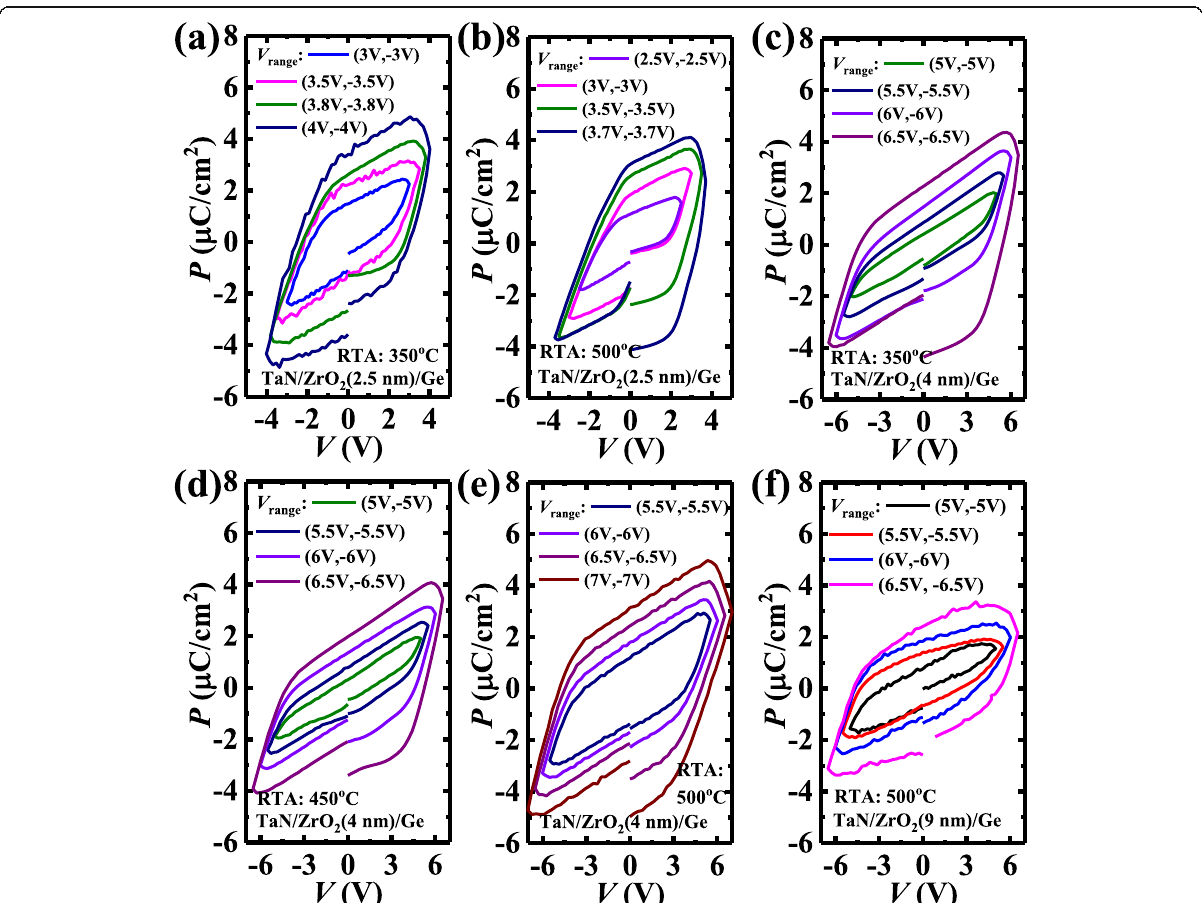
Fig. 2 Measured P vs. V characteristics of the TaN/ZrO 2 /Ge capacitors with different ZrO 2 thicknesses and various annealing